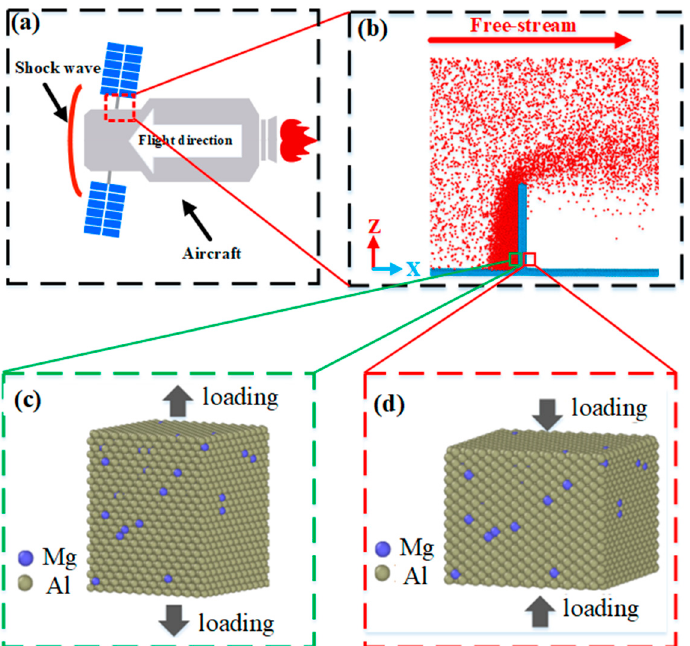
Figure 1. Molecular dynamics model of cantilever beam. ( a ) The structural failure of spacecraft truss structure. ( b ) The simplified truss model for MD simulation. ( c ) The windward region of the model suffers the tensile loading. ( d ) The leeward region of the model suffers the compression loading. The black arrows denote the tensile loading in ( c ) and compression loading in ( d ).